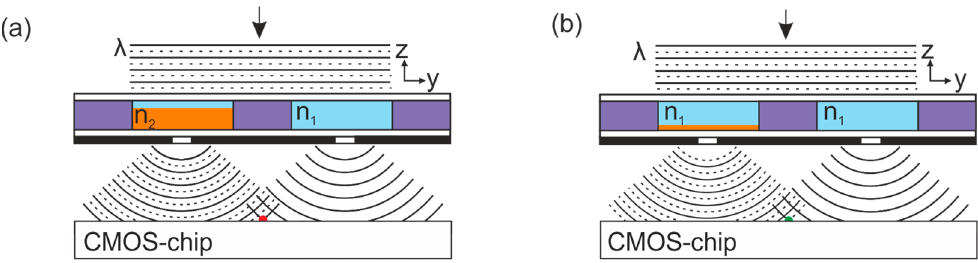
Figure 2. Measurement principle showing a plane-cut of the device along the blue dotted line in Figure 1a in two different states of the L 2 -channel in ( a , b ). Solid (dashed) lines represent a wave-maximum (minimum).